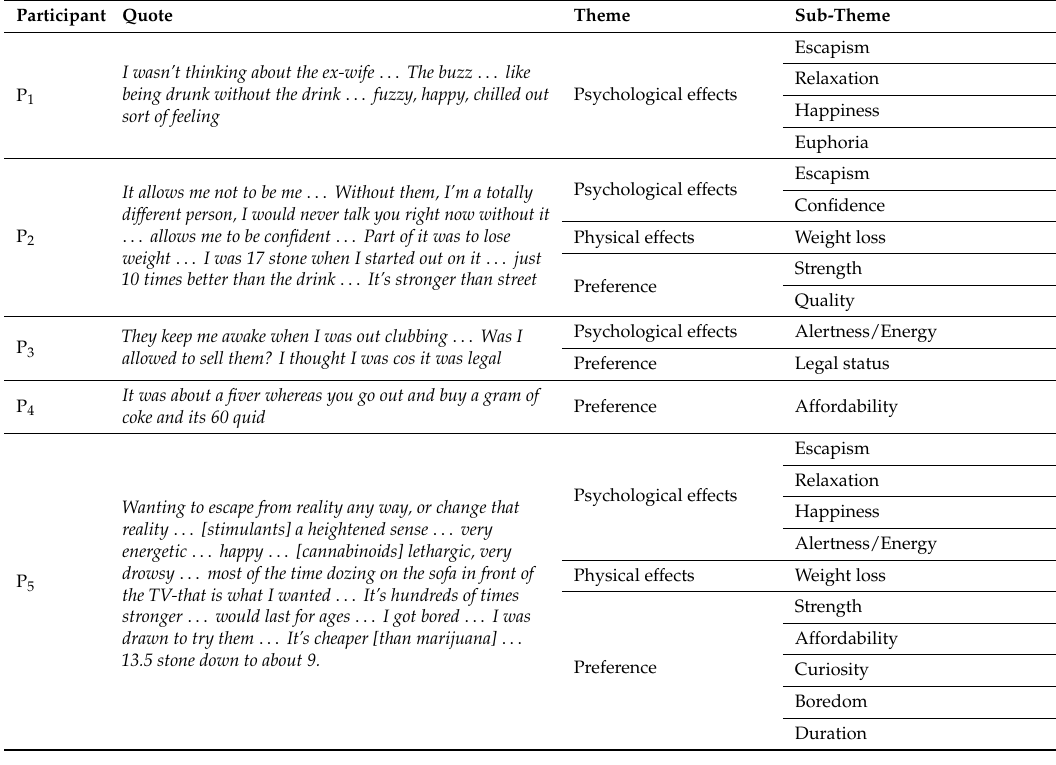
Table 3. Positive experiences associated with NPS use. A list of all the themes and sub-themes, with respective quotes by